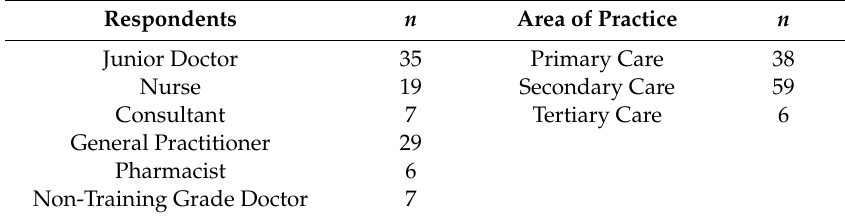
Table 2. Breakdown of pre-study questionnaire respondents by role and area of practice.